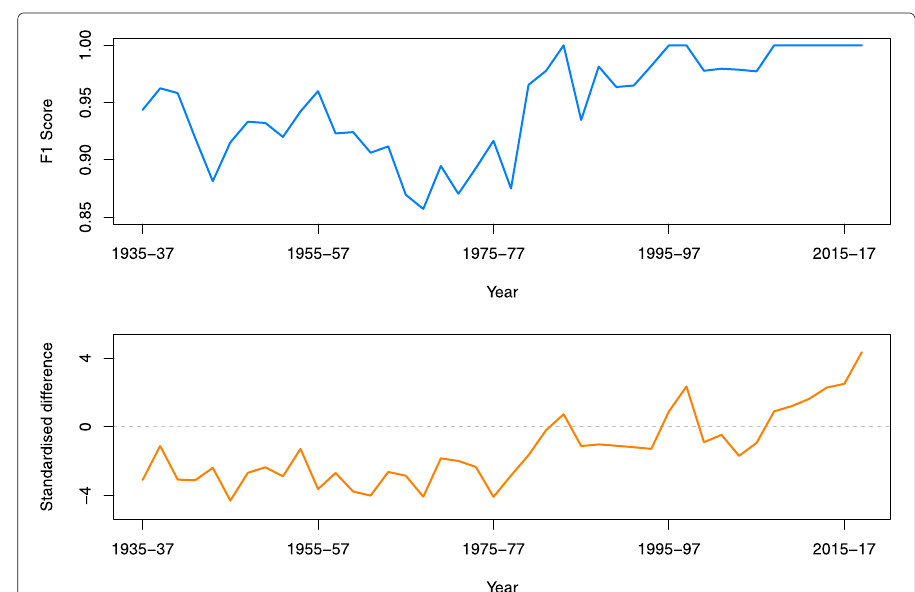
Fig. 3 Top: F1 Score for the Senate from 1935-37 (74 th Senate) to 2017-19 (115 th Senate). Bottom: Difference between the smallest standardised P ( Y i = Democrat ) among all true Democrats and the largest standardised P ( Y i = Democrat ) among all true Republicans for the Senate from 1935-37 (74 th Senate) to 2017-19 (115 th Senate). F1 scores show some variability over time, but are again relatively high for all Senates (minimum F1 score = 0.8571), indicating that the GLaSS method also performs very strongly in labelling members of the Senate as Democrat or Republican. Every Senate since the 110 th (2007-09) has an F1 score of 1, implying complete separation of the parties and perfect performance by GLaSS for those Senates. The Senate also experienced complete separation of Democrats and Republicans in 1983-85, 1995-97, and 1997-99 (98 th , 104 th , and 105 th Senates, respectively). The plot of standardised differences illustrates the magnitude of overlap or separation between Democrats and Republicans in the Senate, as measured by the GLaSS method. Some negative association between F1 score and magnitude of overlap is apparent, while it is also